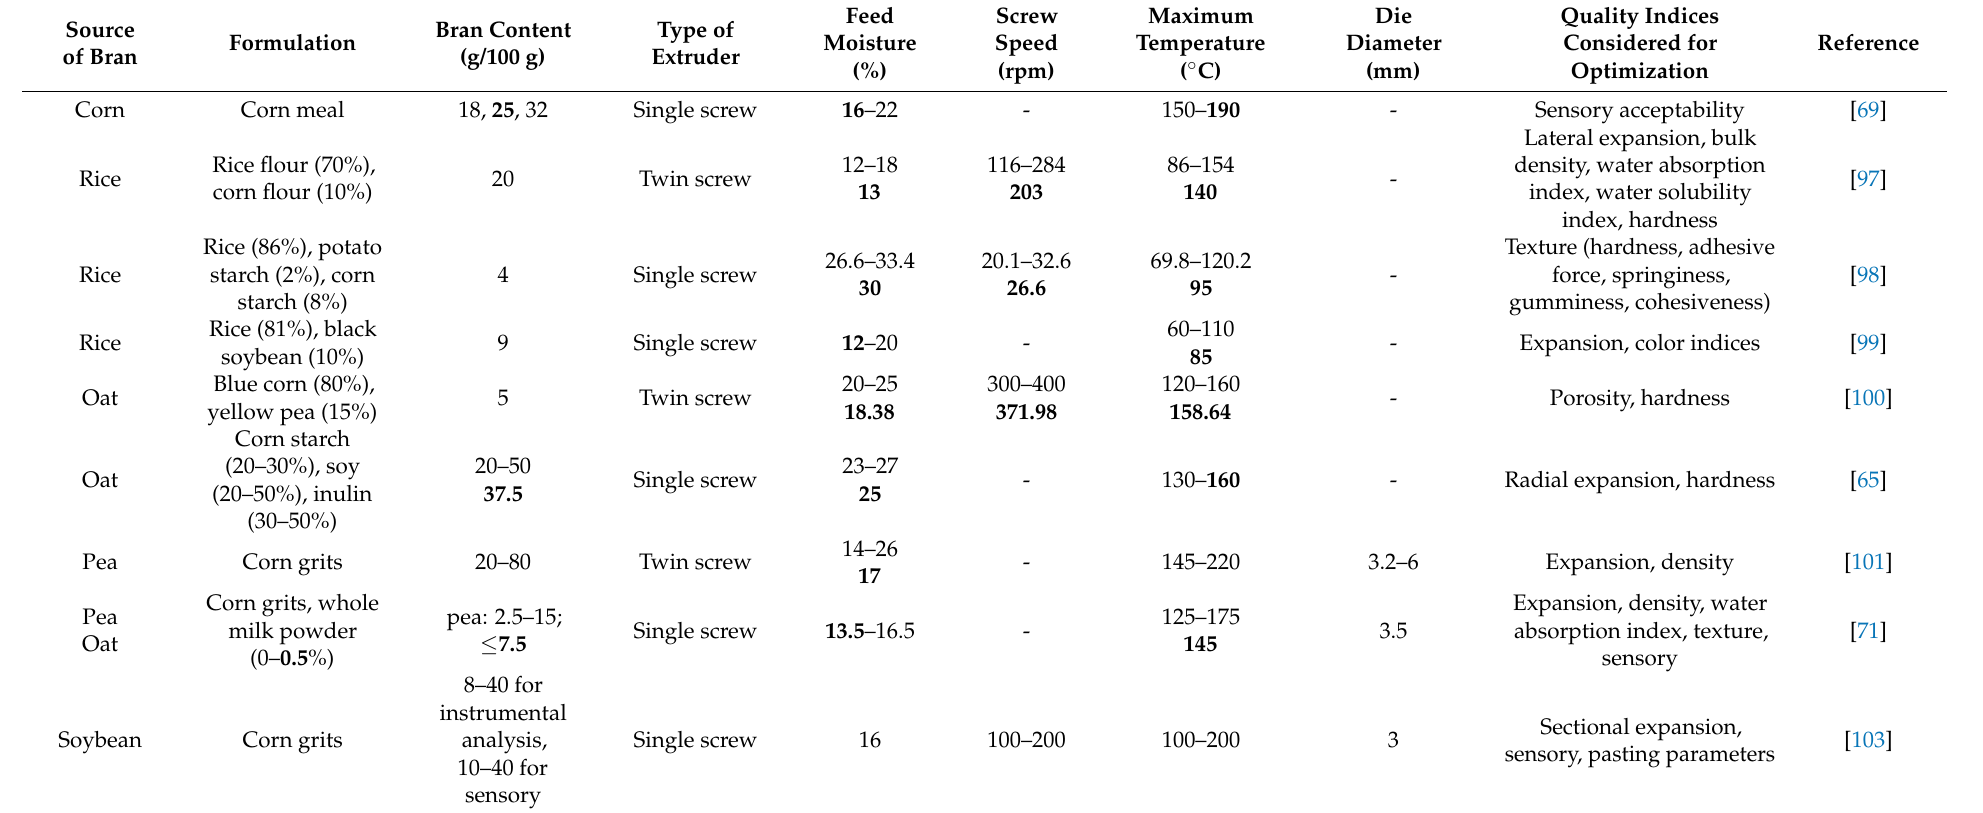
Table 1. The main results of the studies aimed at identifying the optimal processing conditions for the production of bran-enriched snacks. Values specified by authors as optimum (within the tested conditions) are highlighted in